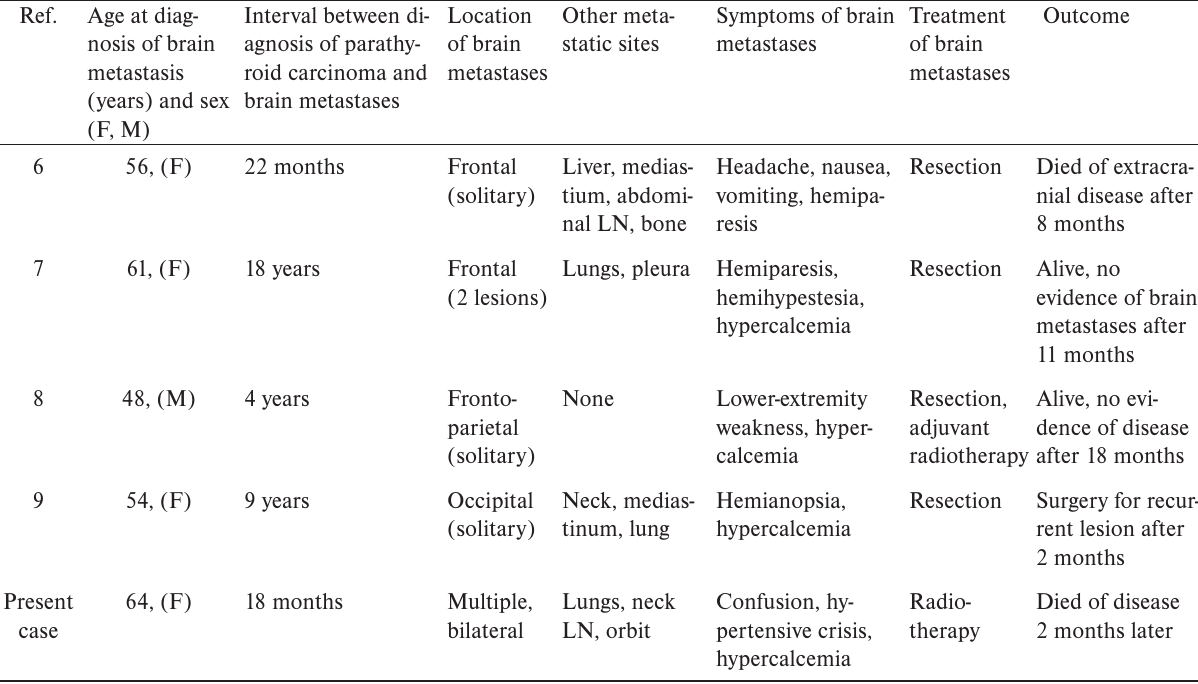
Table 1. Cases of parathyroid carcinoma brain metastases reported in the literature.